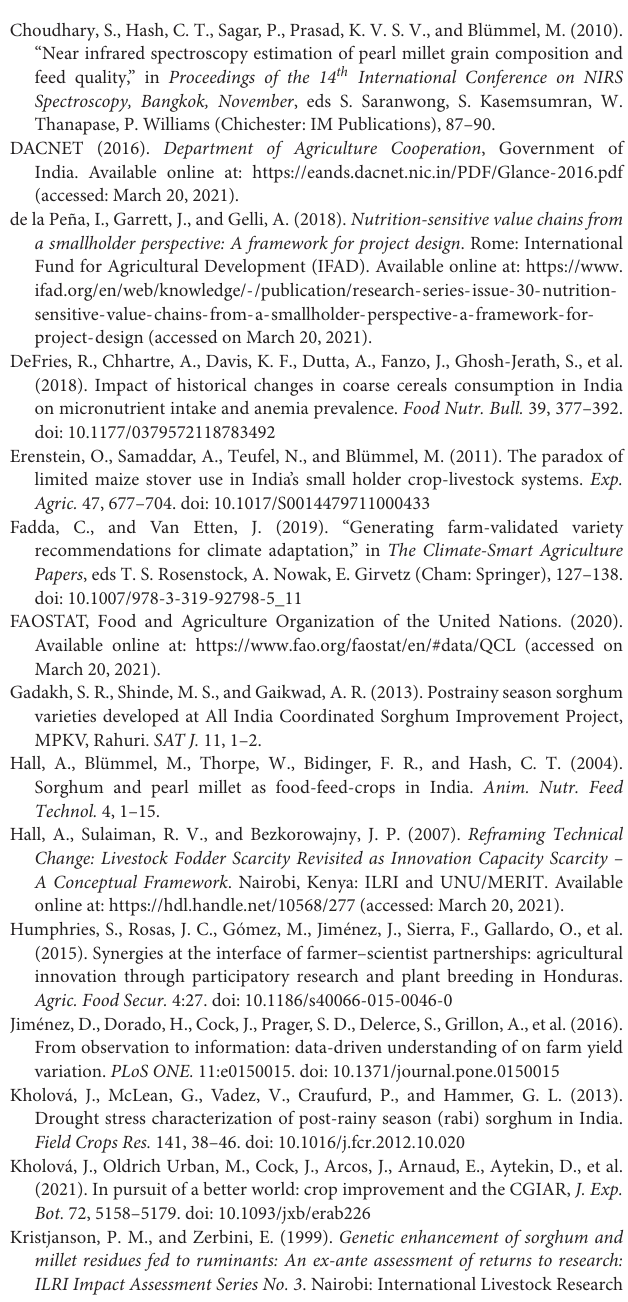
Supplementary Figure 1 | (A) Trait relationship between grain yield (g plant − 1 ) and harvest index (HI); and (B) regression plot between the residual of grain yield not explained by HI vs. stover yield (g plant − 1 ) in water stressed (WS) and well-watered (WW) plants across four genotypes tested in 2019–20 lysimetric trial.